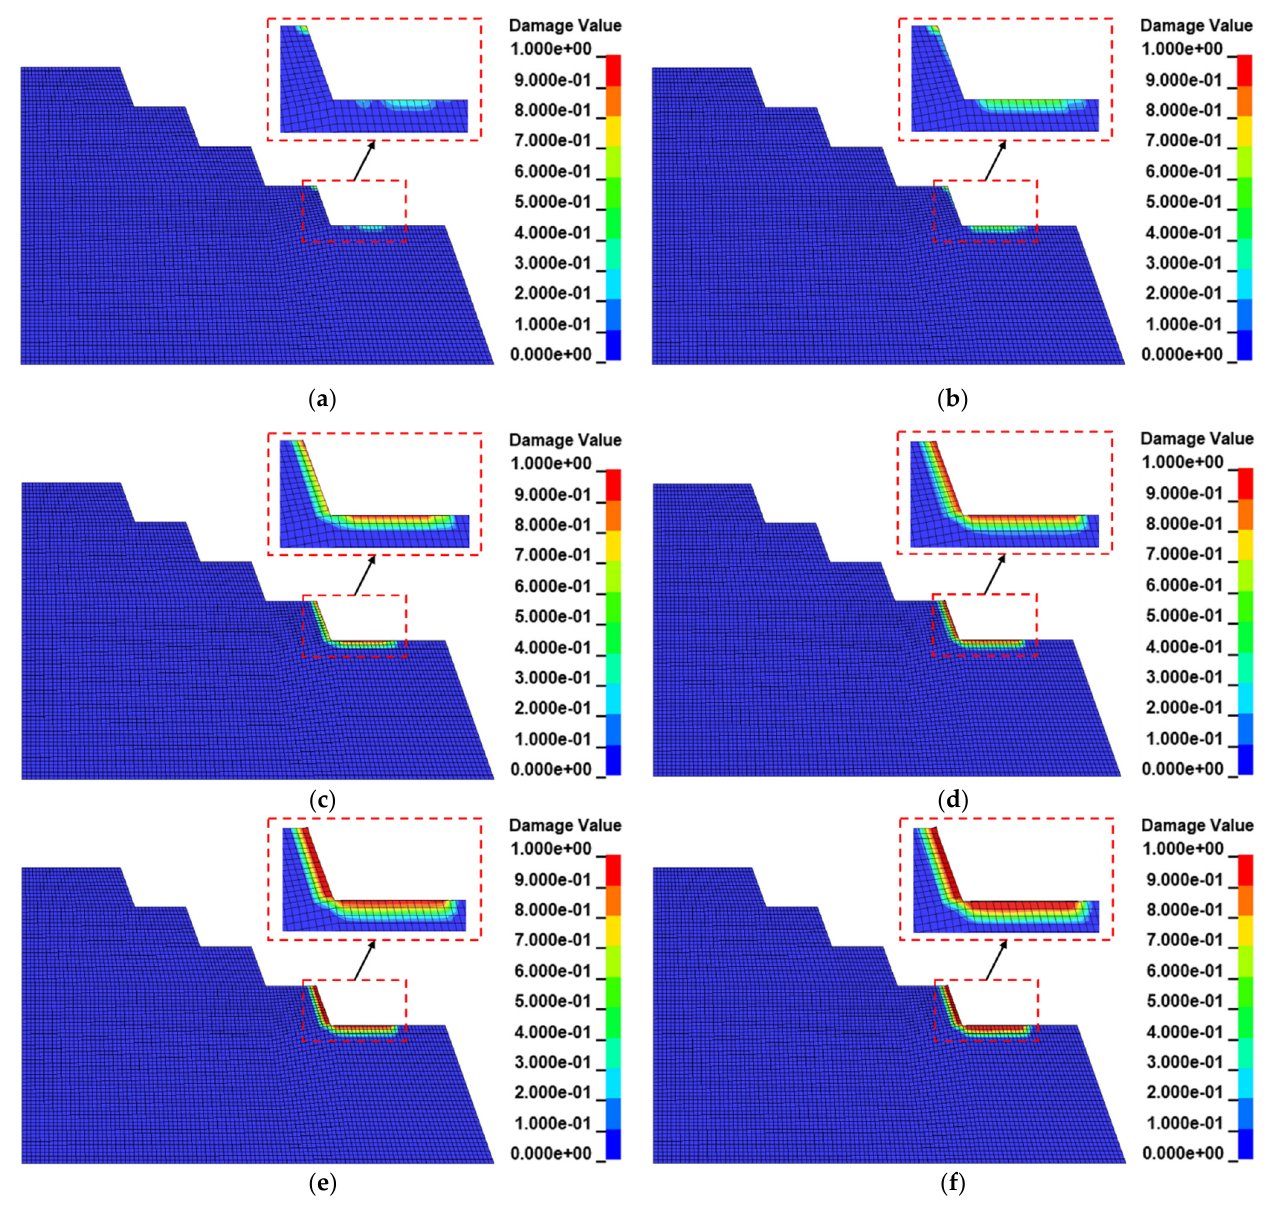
Figure 7. Damage distribution of the reserved rock mass during blasting excavation: ( a ) 0.1 ms; ( b ) 0.2 ms; ( c ) 0.3 ms; ( d ) 0.4 ms; ( e ) 0.5 ms; ( f ) 0.6 ms.